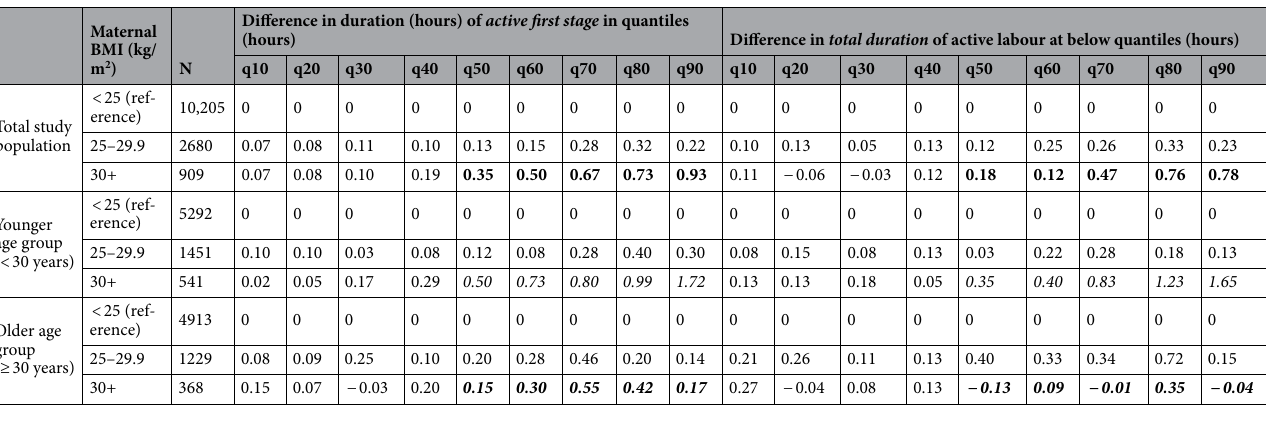
Table 3. Difference in labour duration at different quantile levels, comparing the obese, over- to normal- weight group based on the total study population and two age subgroups separately.